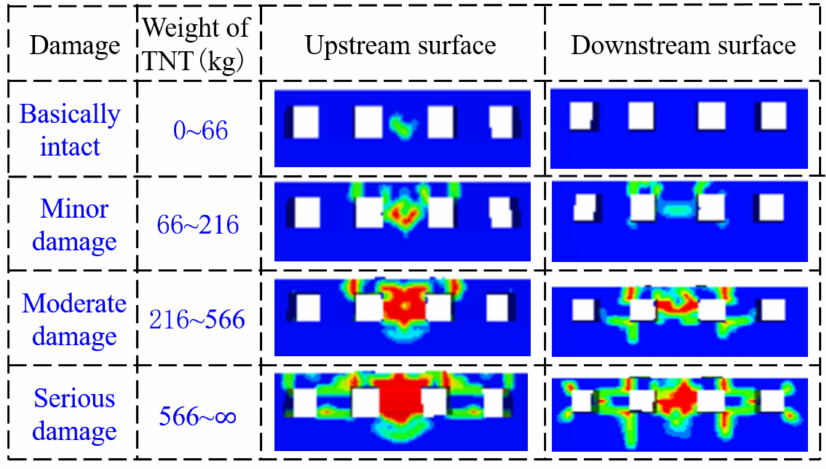
Figure 9. The degree of damage to the surface flood discharge holes for different masses of explosive.